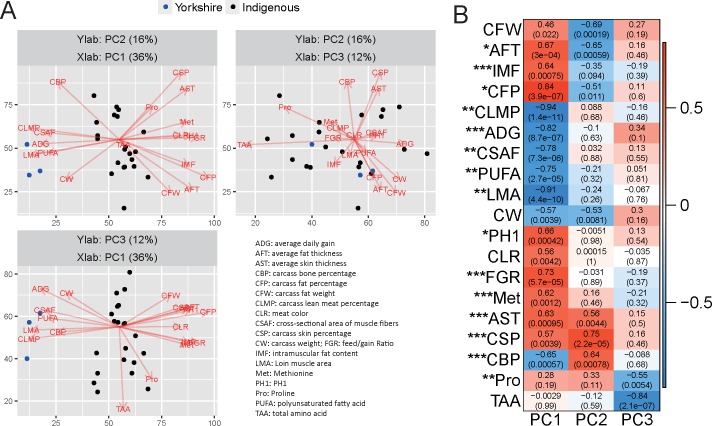
PCA analysis on the 101 phenotypic traits of the pigs.(A) Bi-plot of the loadings and scores of the three PCs. For clarity, traits in red vectors are those with a significance level of the correlations between traits and the loadings < 0.01, and further selected for the representative traits. Trait abbreviations are provided in the lower right panel. Blue and black dots represent YY and Chinese breeds, respectively. (B) Correlations of the presented phenotypes to the loadings of the three PCs. Pearson’s correlation coefficients (the numbers outside parentheses) and significant P values of the correlation (within parentheses) are provided in the cell; red represents a positive correlation and blue represents a negative one. Asterisks before the traits indicate the significance of the difference between the Chinese breeds and YY. * P<0.05; ** P<0.01; *** P<0.001.